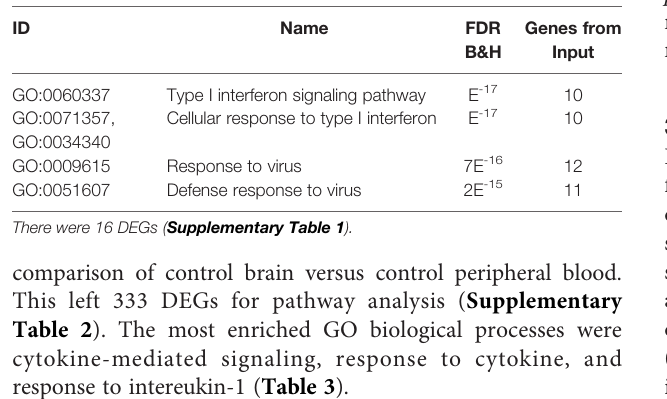
TABLE 2 | Enriched biological processes (B&H FDR < 0.05) for brain-stimulated vs. fl u-stimulated MS blood cells.